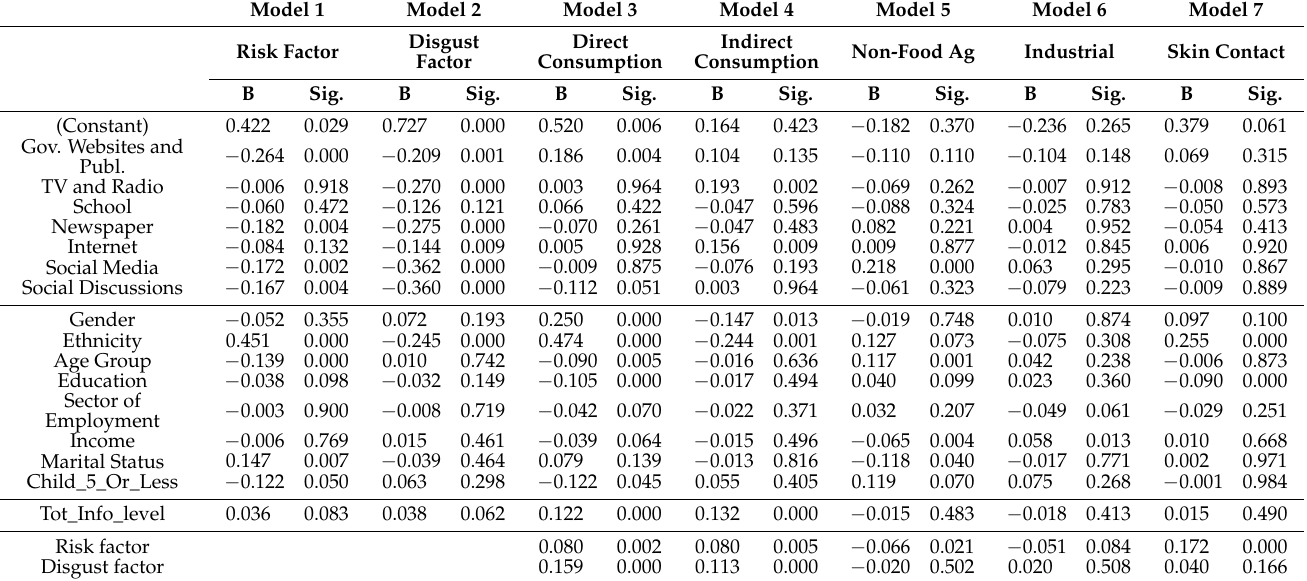
Table 7. Regression results on wastewater recycling hesitation and acceptance